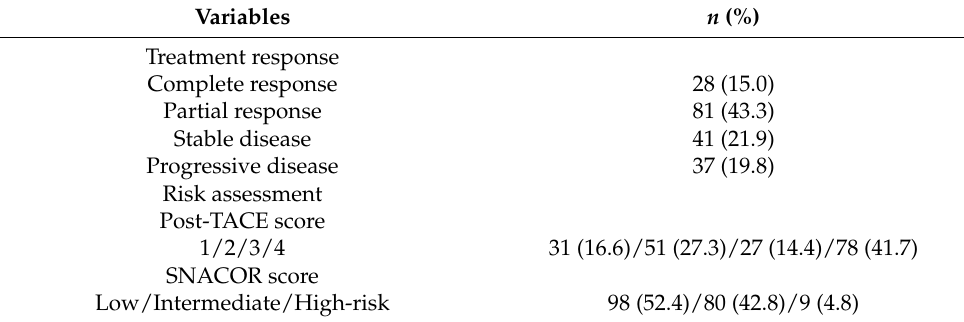
Table 3. Treatment response after the first TACE and risk assessment.